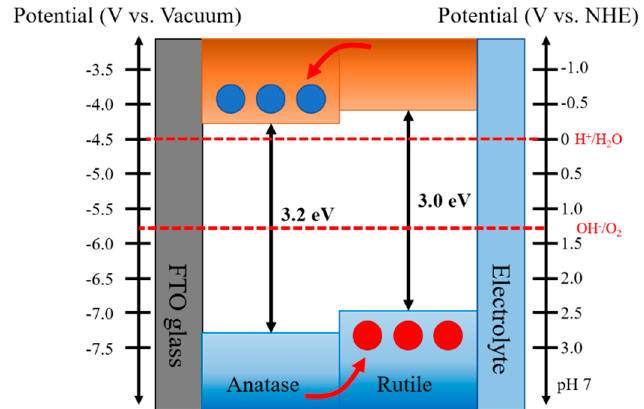
Figure 4. Schematic of the type-II band alignment staggered with the conduction band and valence band energy levels of rutile lying above those of anatase for anatase—rutile heterophase junctions, illustrating a plausible charge separation and transfer processes across the phase junction.